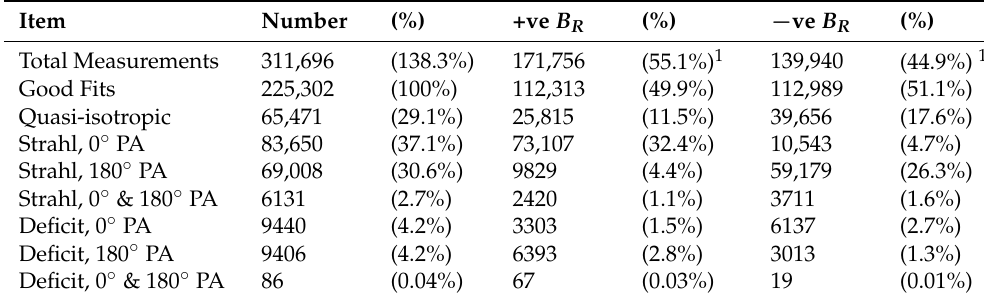
Table 1. Occurrence statistics for strahl beams and deficits in >70 eV solar wind electron